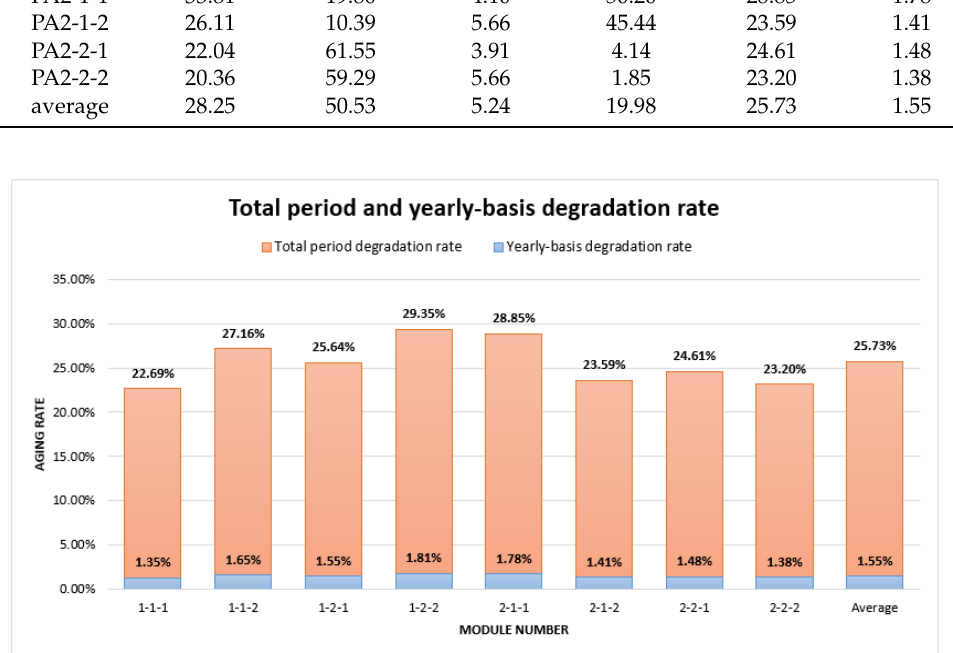
Figure 11. Total period and yearly-basis degradation